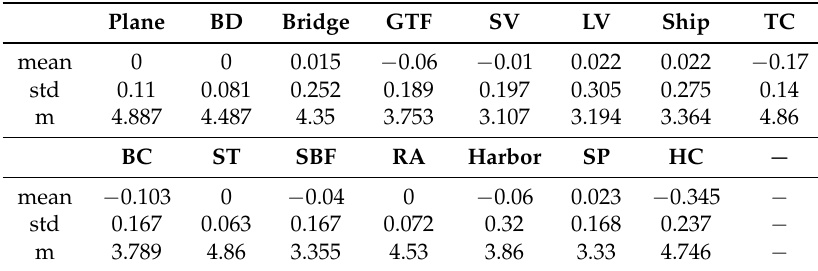
Table 8. The mean, standard deviation, and corresponding constraint factors of the distribution of different classes of samples L_AR.